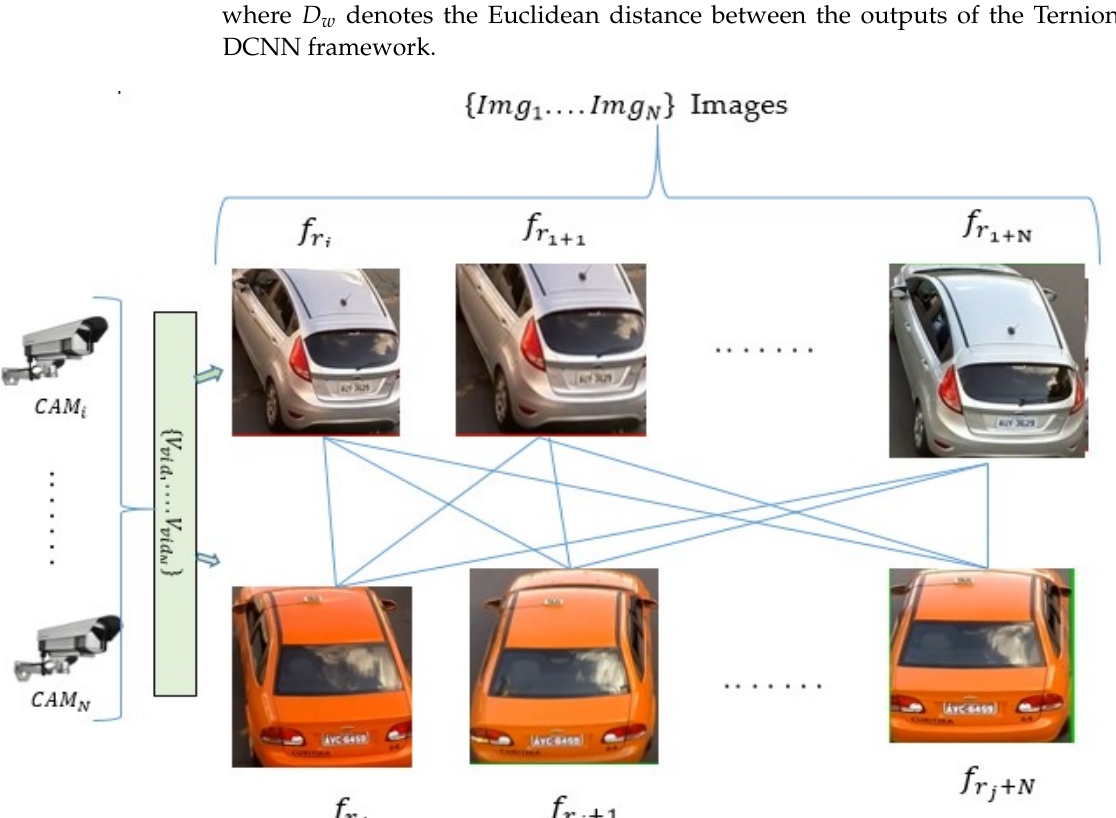
(cid:8) (cid:9) } V vid . . . V vid , { f r . . . f r . ... 𝑉 (cid:3049)(cid:3036)(cid:3031) } , N 1 N 1 (cid:3117) (cid:3263)